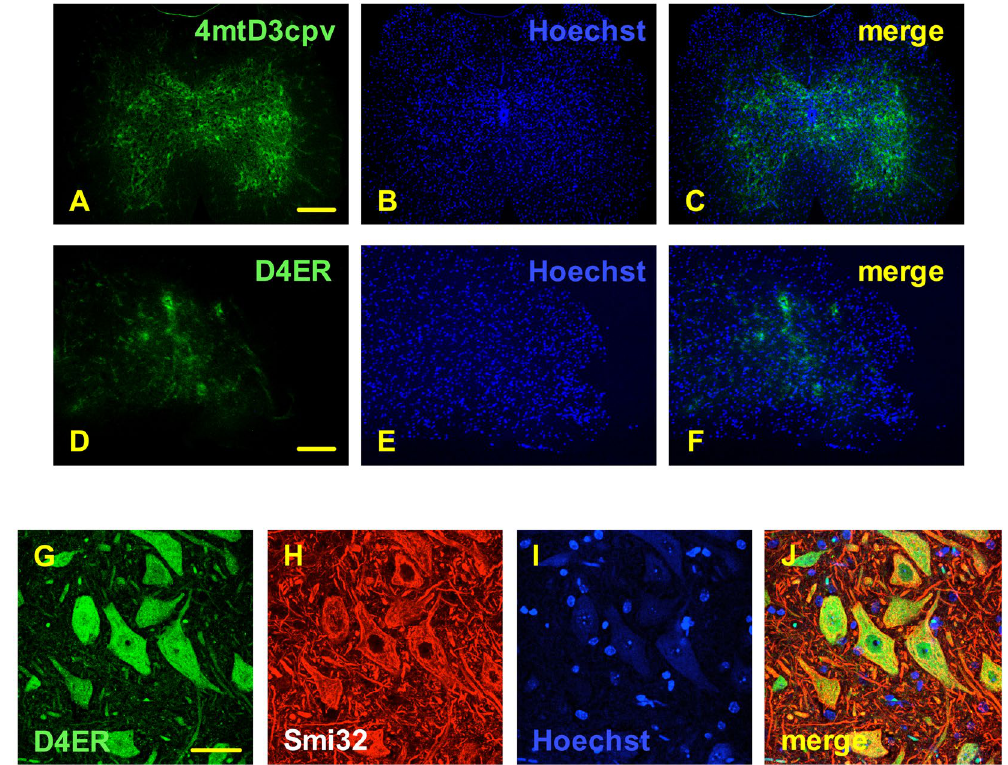
Figure 5. The MN promoter-driven cameleons can be efficiently and specifically expressed in MNs after transduction of mice with the AAV vectors in vivo . Neonatal mice (P1) were injected into the temporal vein with AAV vectors encoding the mitochondrial (panels A–C) or the ER (panels D–J) cameleon. Mice were sacrificed 4 weeks after injection, and spinal cord cross-sections were labeled with the nuclear fluorescent dye Hoechst 33342 (panels B,E,I) and immunostained with the MN marker SMI32 (panel H), and then observed with a fluorescence stereo-microscope (panels A–F) or a confocal microscope (panels G–J). Low-resolution stereo-microscopy images show a diffuse expression of both fluorescent Ca 2 + probes (green signal, panels A,D,G), indicating that the cameleons are effectively transduced and expressed in the spinal cord in vivo . The merged reconstruction of complete z-stacks of cells collected by confocal microscopy shows that the D4ER cameleon is expressed only in SMI32-immunopositive MNs (merged image, panel J), suggesting the cell-specific expression of the probe. Scale bars = 200 µ m (A–C), 100 µ m (D–F), 10 µ m